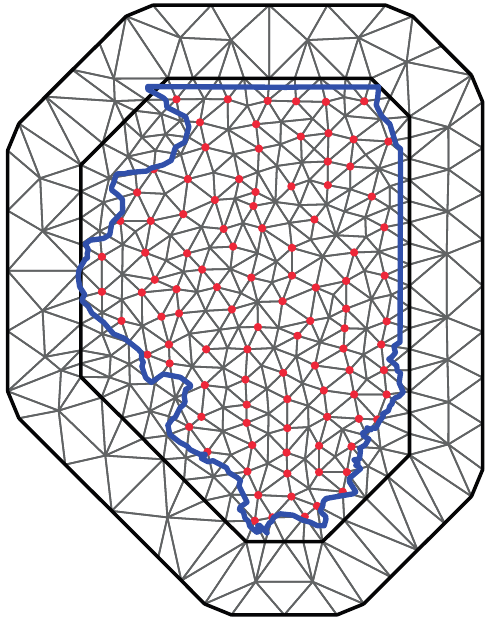
Figure 2. INLA mesh for the study region, blue line represents the border for the state of Illinois, and red dots represent the coordinates for the county seats.